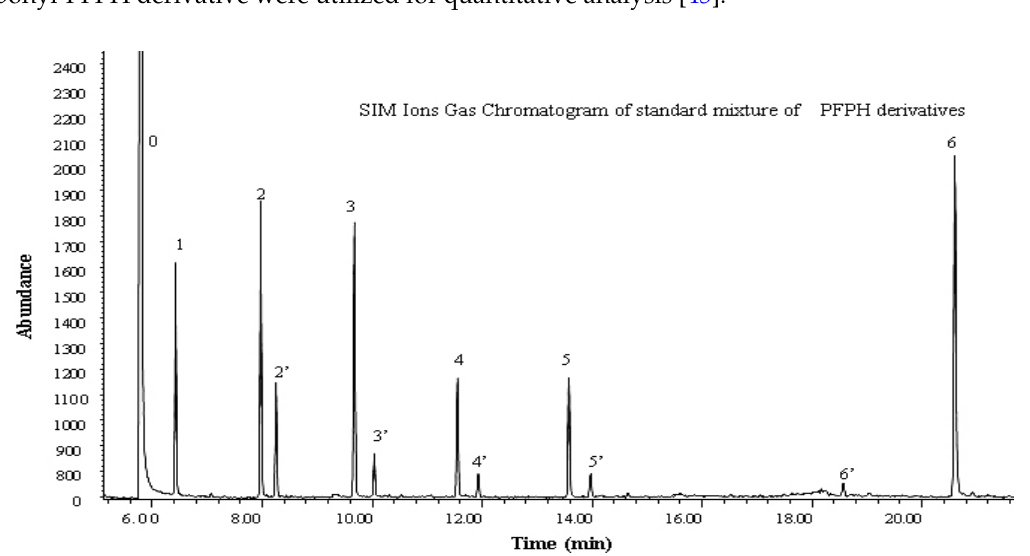
Figure 2. SIM Ion: selective ion monitoring ion Gas Chromatograms of standard mixture of Pentafluorophenyl hydrazine (PFPH) derivatives. Peaks 0: PFPH; 1: formaldehyde; 2 and 2 ′ : acetaldehyde; 3 and 3 ′ : propionaldehyde; 4 and 4 ′ : n-butyraldehyde; 5 and 5 ′ : valeraldehyde; 6 and 6 (cid:48)